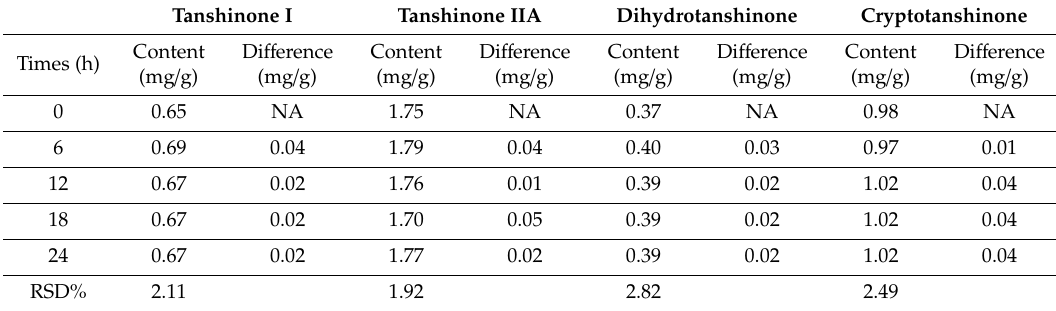
Table 2. Results for the stability